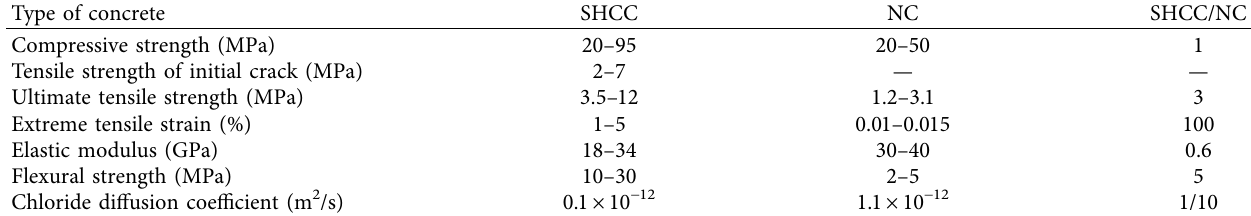
Table 1: Main performance index comparison between SHCC and NC [16].